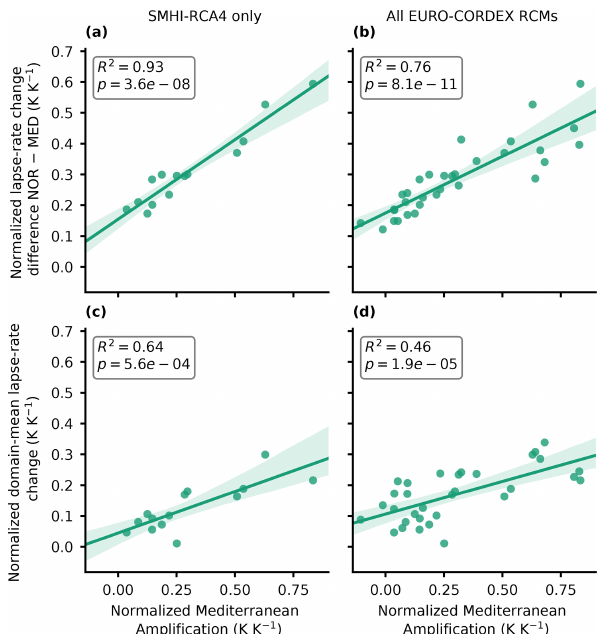
Figure 7. Linear regression linking the enhanced Mediterranean summer 2m warming to lapse-rate changes in the EURO-CORDEX ensemble. (a, b) Regression linking the Mediterranean amplifica- tion and differences in lapse-rate changes between northern Eu- rope (NOR) and the Mediterranean (MED) over land. (c, d) Re- gression linking the Mediterranean amplification to the European- scale domain-mean lapse-rate change. (a, c) A subset of the EURO- CORDEX ensemble using one single regional climate model, namely SMHI-RCA4. (b, d) All EURO-CORDEX simulations that were used in this study (Table A1). Each dot represents a simulation with a horizontal resolution of 0.11 or 0.44 ◦ . The figure is based on summer-mean (JJA) changes between 1971–2000 and 2070–2099, assuming RCP8.5. We normalized both the Mediterranean ampli- fication and lapse-rate changes with the domain-mean warming, yielding dimensionless values (K / K). The lapse-rate changes have been computed as the difference between the 500hPa warming and the 850hPa warming. We evaluate the Mediterranean between 30 and 44 ◦ N and northern Europe between 55 and 70 ◦ N. The boxes in the upper left corner of the panels show the statistics of the linear regression fit, while the shadings show the 95% confidence interval of the linear regression estimated by 1000-fold